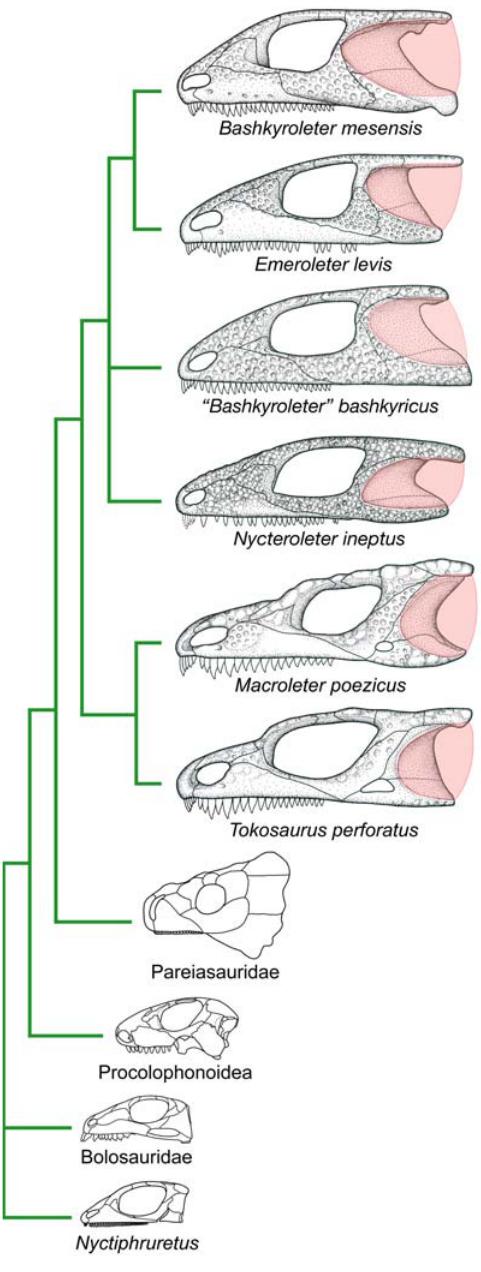
Figure 1. Phylogeny of the non-pareiasaurian parareptiles from the Mezen River Basin. With the exception of Nyctiphruretus , all relevant taxa form a clade that is sister to Pareiasauridae, and are characterized by the presence of a large temporal emargination indicative of a prominent tympanum (in pink). Not to scale.